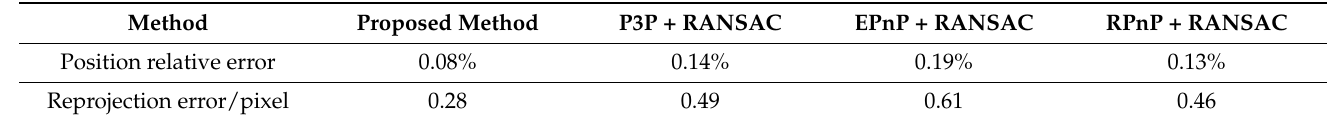
Table 1. Position relative error and reprojection error in real